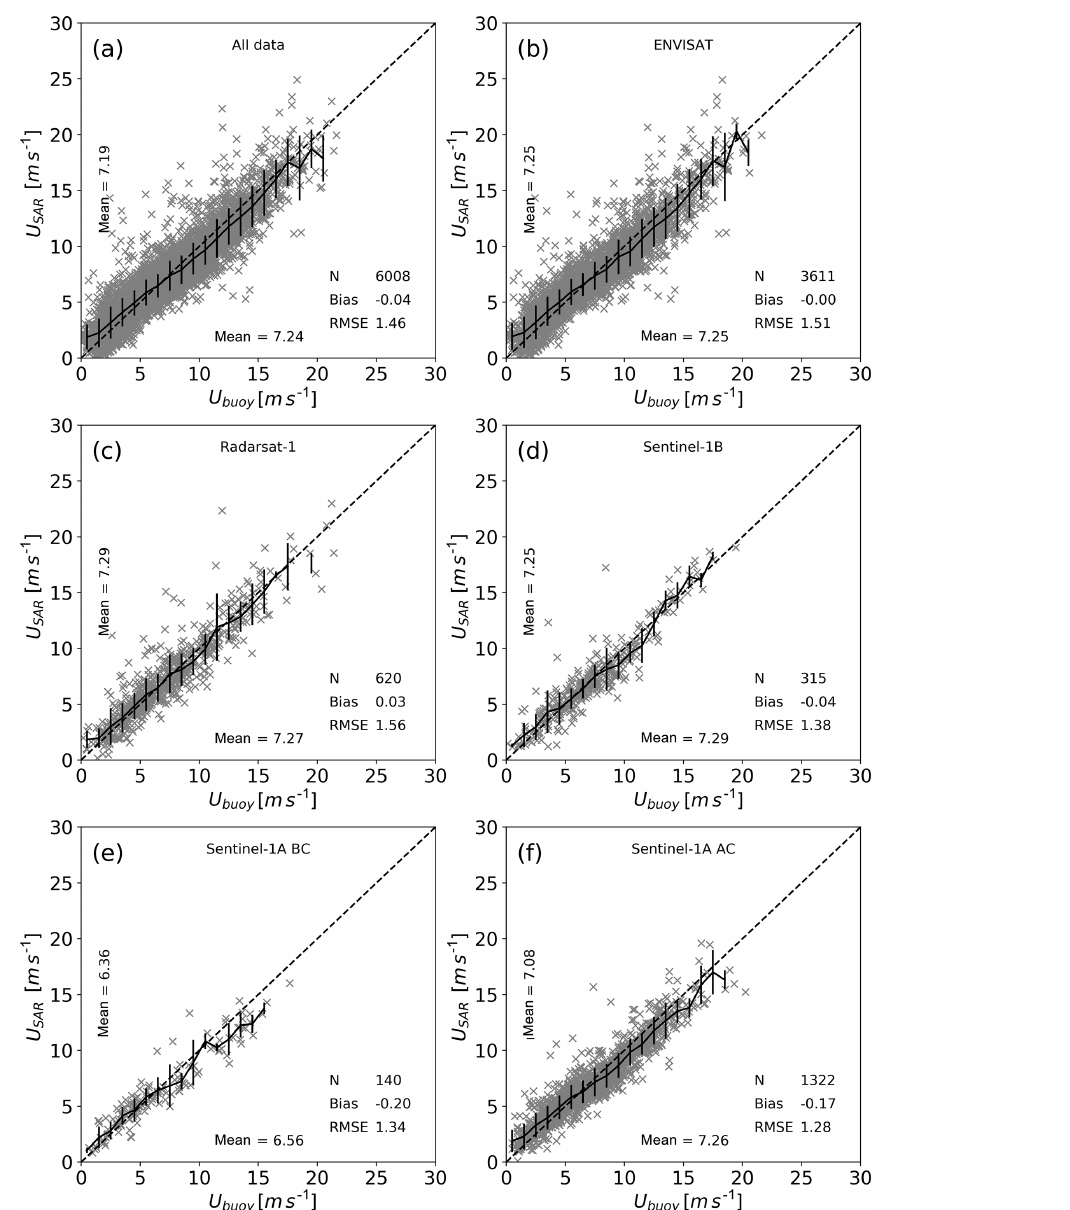
Figure 3. Scatter plots of intercalibrated SAR versus buoy winds at 10m for (a) all data, (b) Envisat, (c) RADARSAT-1, (d) Sentinel-1A BC, (e) Sentinel-1A AC, and (f) Sentinel-1B. The black curves indicate the mean within each 1ms − 1 bin, and the vertical lines around the mean value indicate 1 standard deviation within this